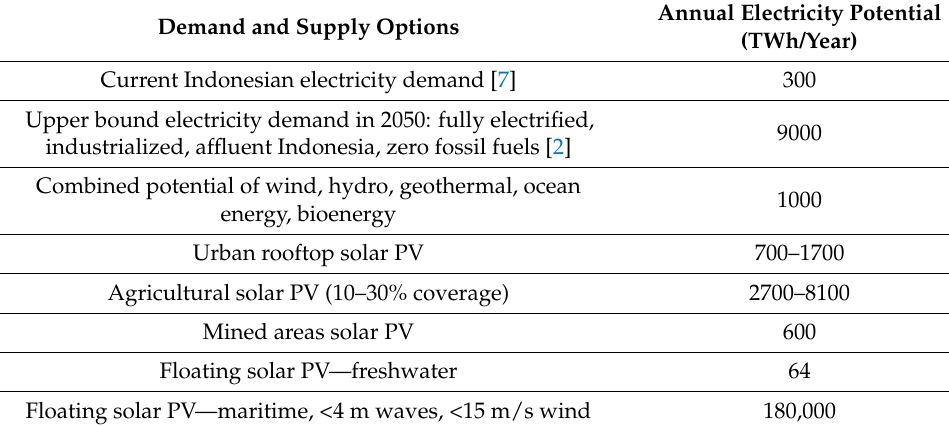
Table 1. Electricity demand and renewable supply options in Indonesia (from Table 11 in ref